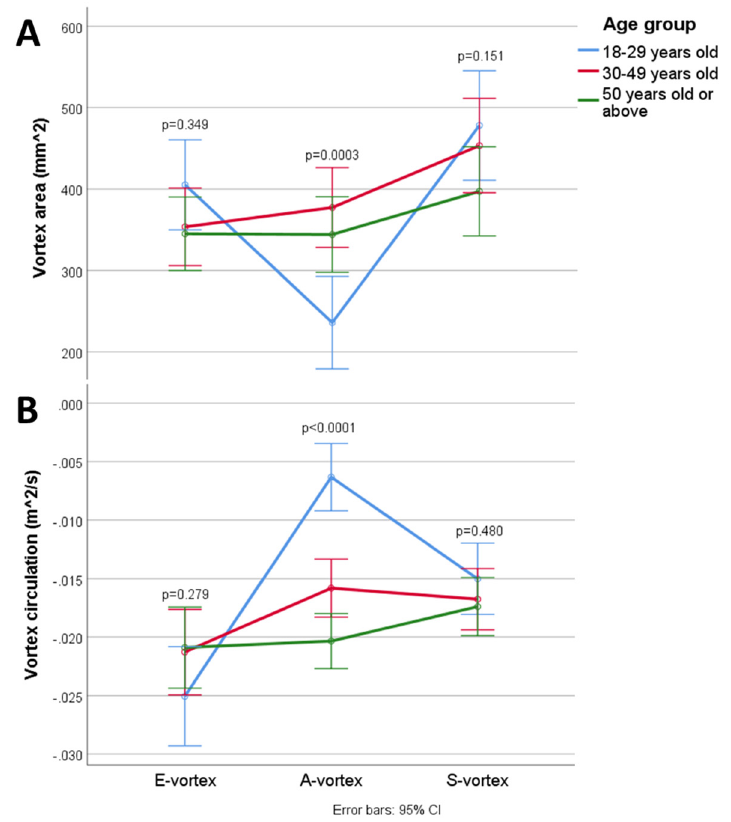
Figure 3. Changes in the ( A ) vortex area and ( B ) circulation in the cardiac cycle.